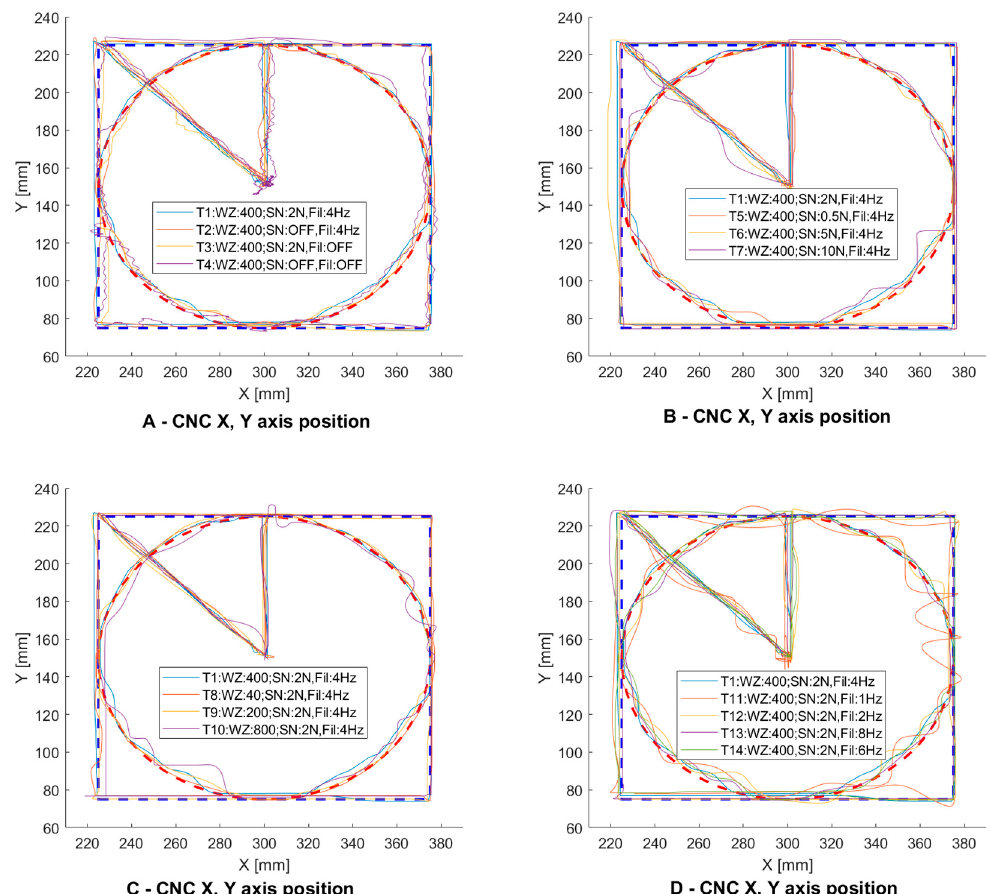
Figure 9. Functional diagram of the parameter (SN, WZ, Fil) selection algorithm for the system operator.